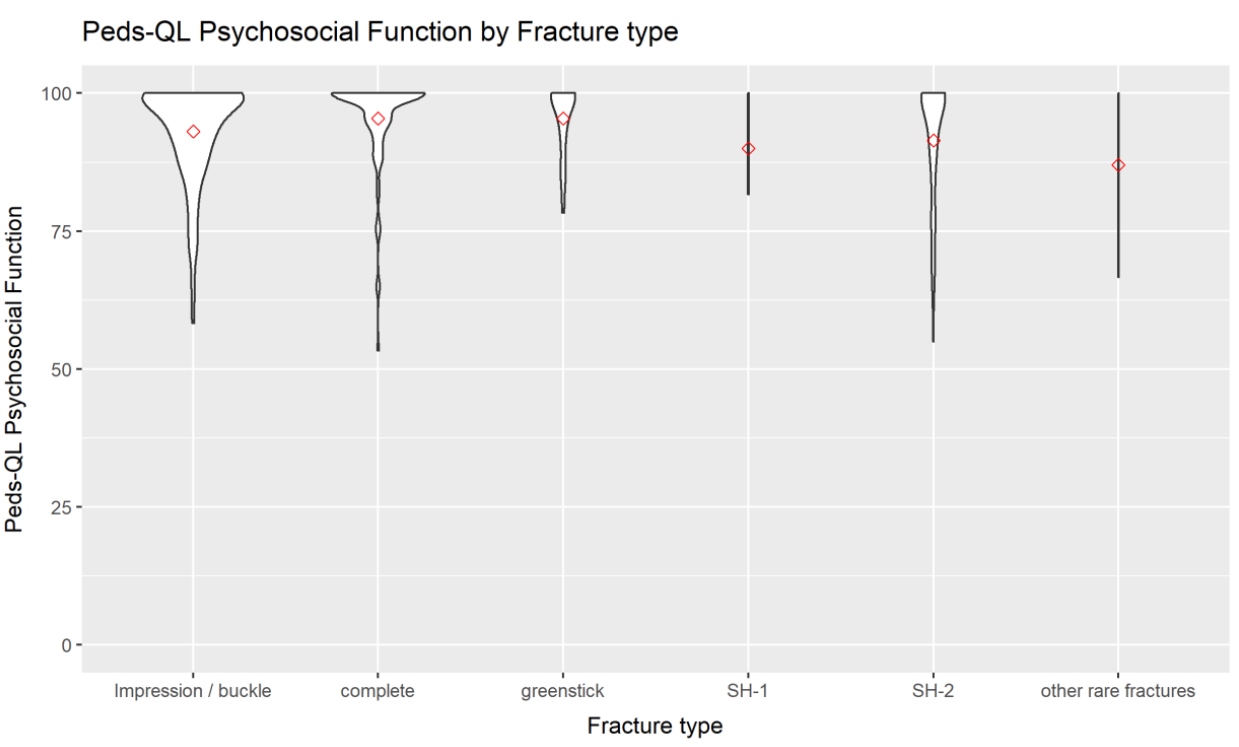
Figure 3. Peds-QL physical function at follow-up by fracture type of the radius.